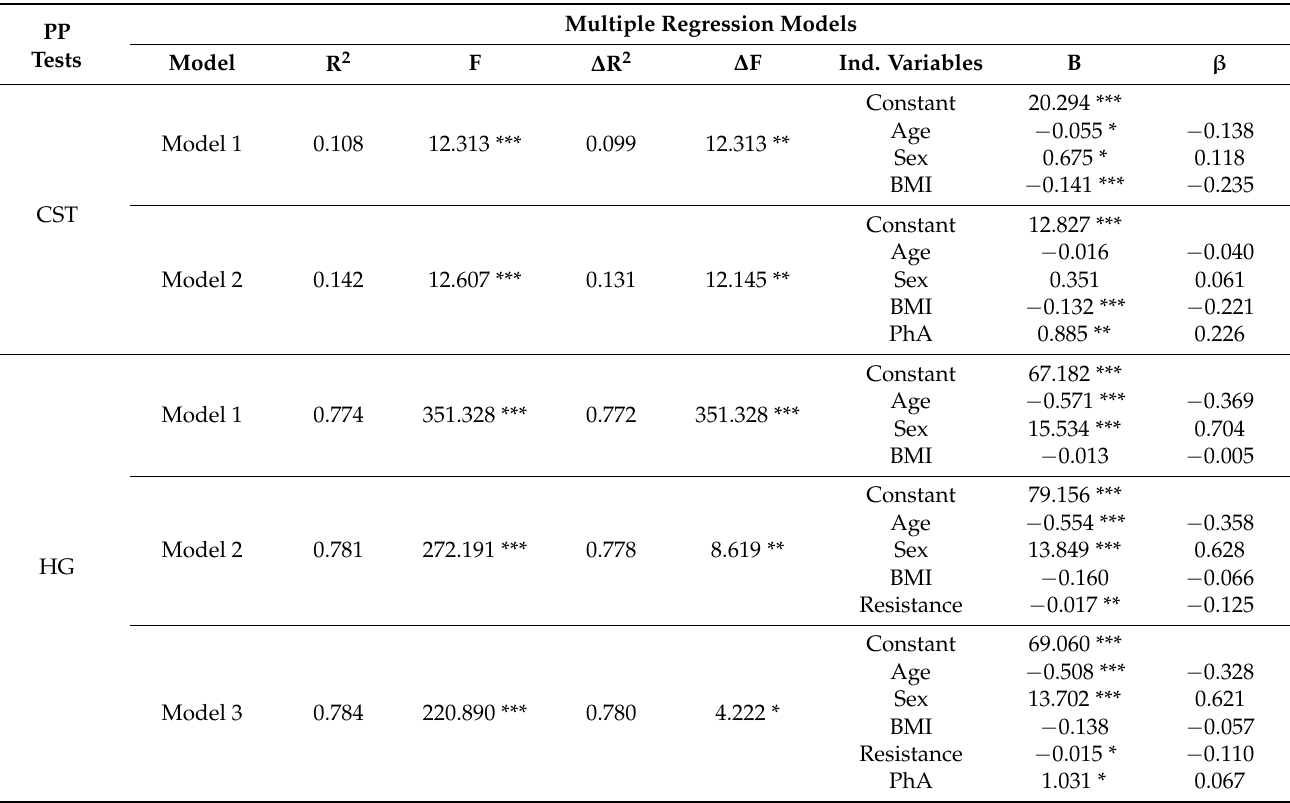
Table 5. Hierarchical multiple regression results for the physical function tests and physical perfor- mance